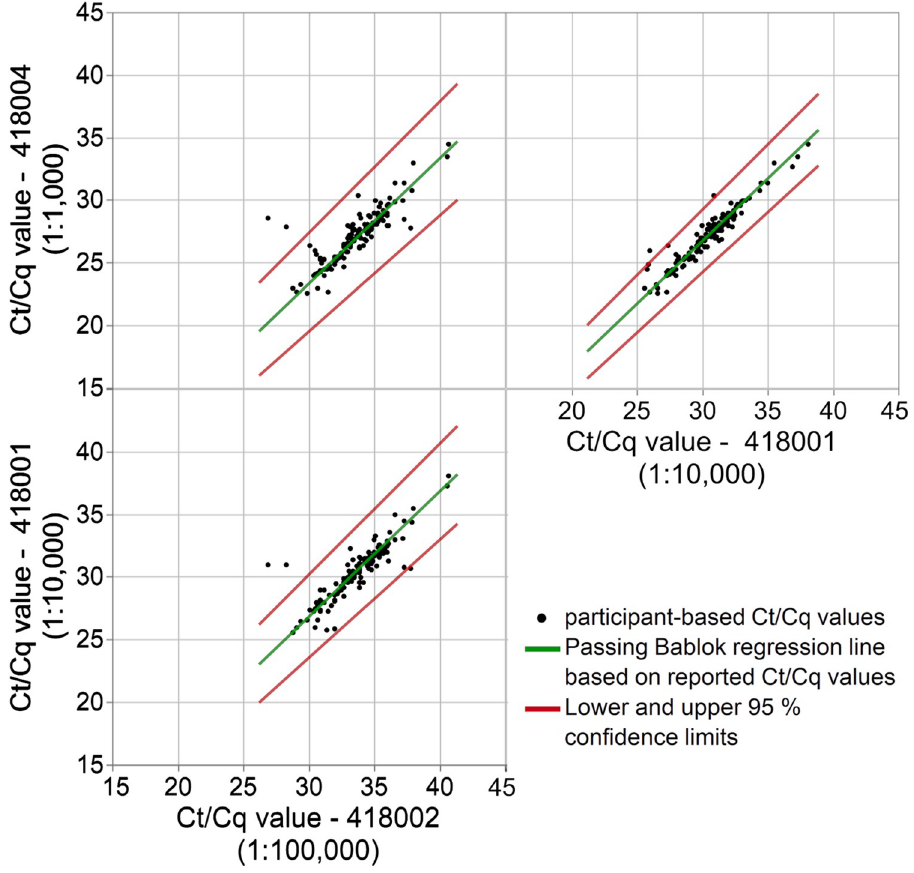
Fig 3. Passing Bablok fit of laboratory-based Ct/Cq values (black dots) for all pairs of EQA samples, differing in concentration by a power of ten. The Passing Bablok regression line (green) is shown with the lower and upper 95% confidence limits